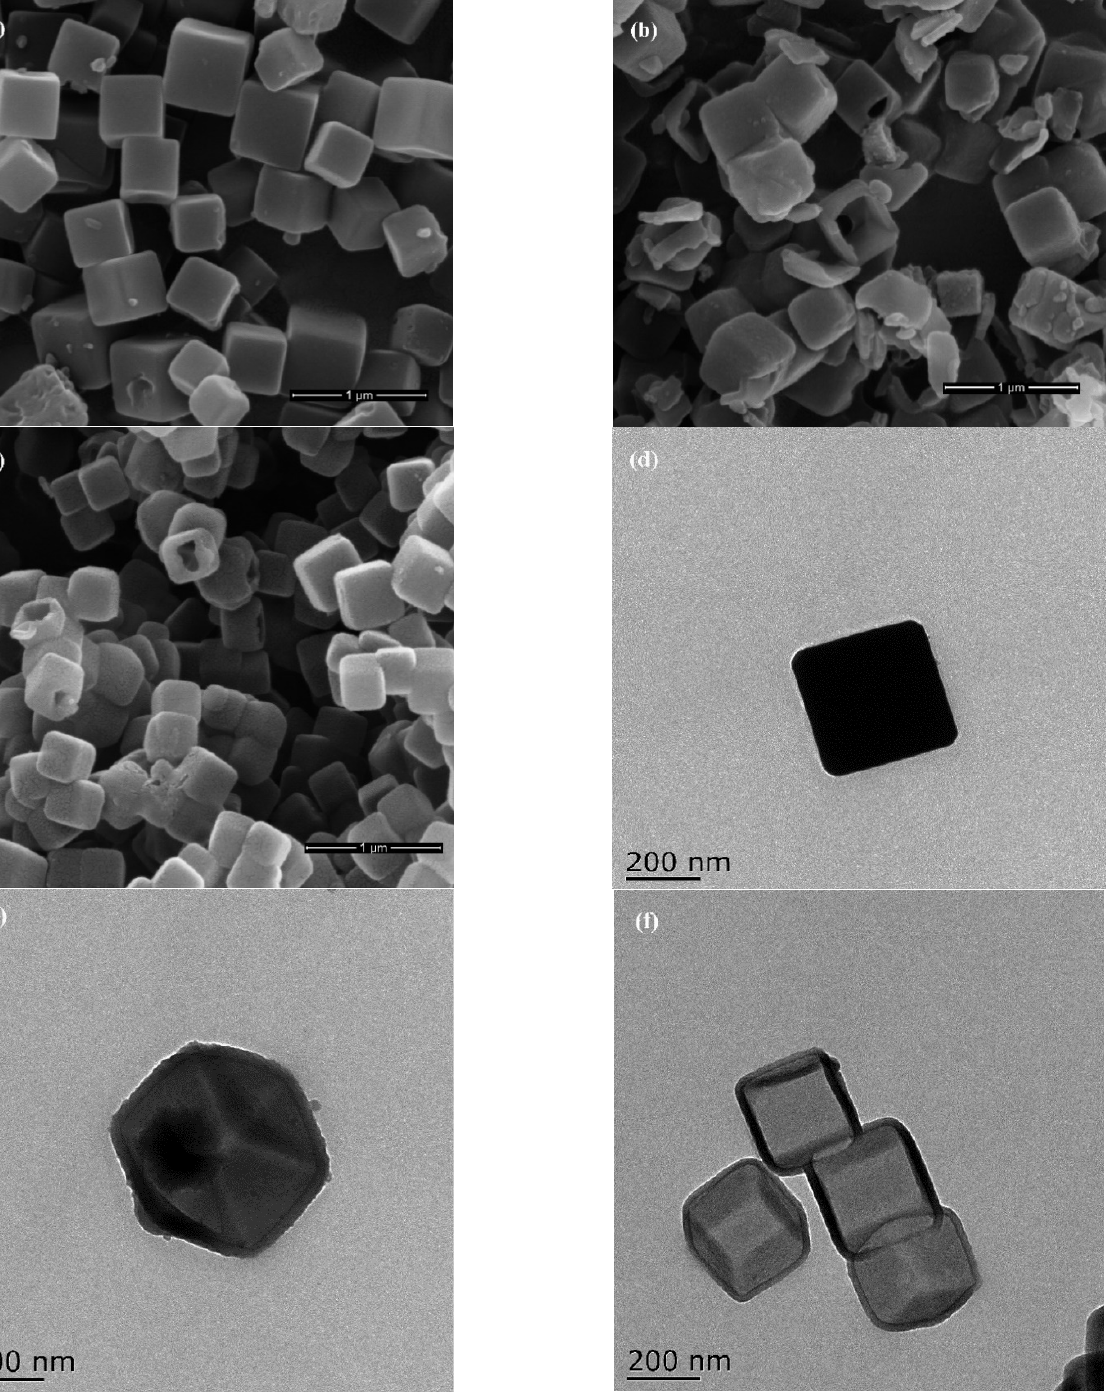
Figure 2. SEM images of ( a ) ZIF-8, ( b ) HZIF-8 and ( c ) HZCs in the top row followed by.TEM images of ( d ) ZIF-8, ( e ) HZIF-8 and ( f ) HZCs. The TEM image further reveals the solid cubic structure of ZIF-8 (Figure 2d). The hollow structure can also be observed from the TEM image of HZIF-8 in Figure 2e, which indicates that the TA etching process could successfully transform a solid structure of ZIF- 8 into a hollow structure. During the etching process, free protons from TA could break the framework of ZIF-8 and penetrate into it. Furthermore, because of the coating on the